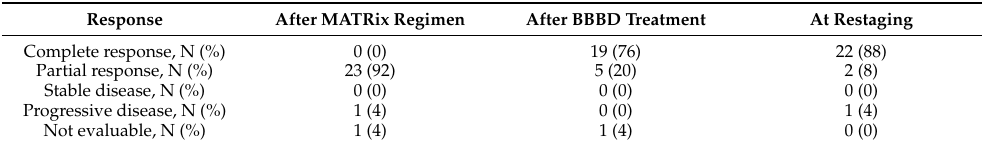
Table 3. Responses after the MATRix induction (1 cycle), after BBBD a treatment, and at restaging.